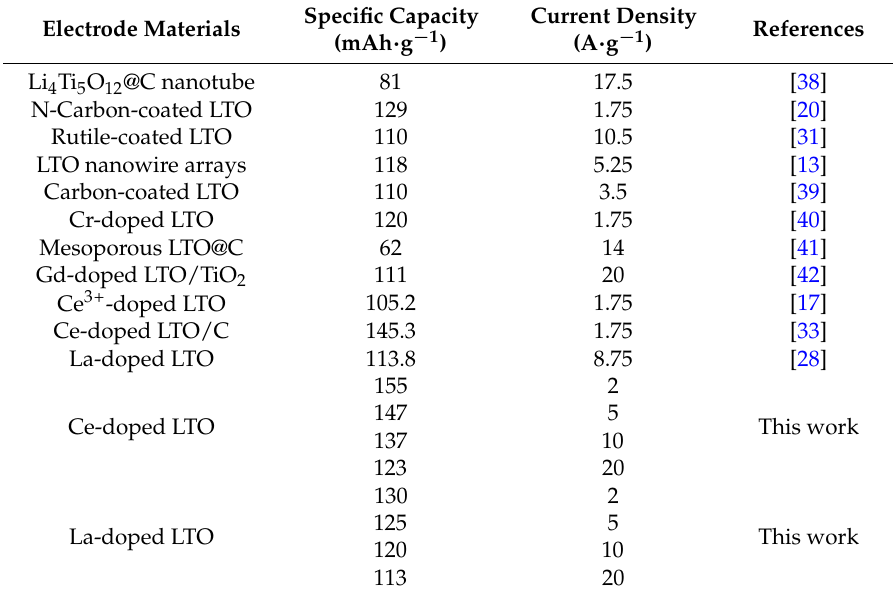
Table 1. Comparison of the electrochemical performance for the LTO electrode based on the Li-half cell. Electrode